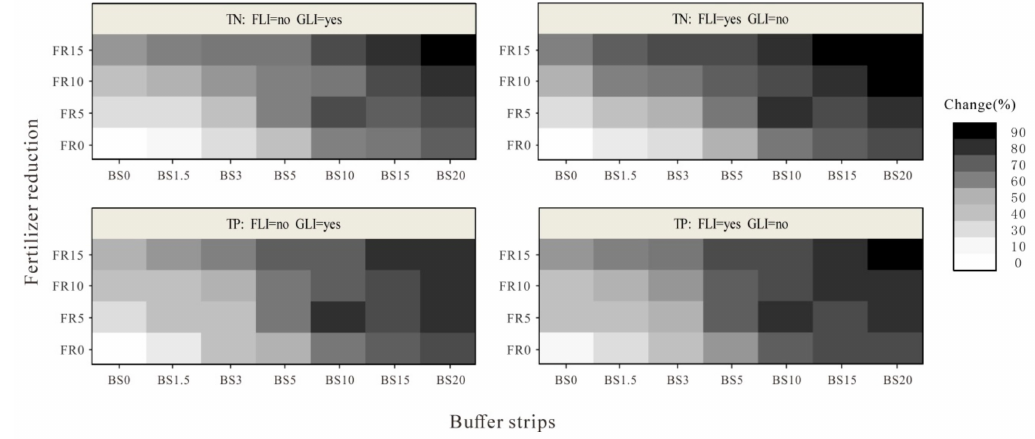
Figure 10. TN and TP loads reduction in the di ff erent combinations of BMPs